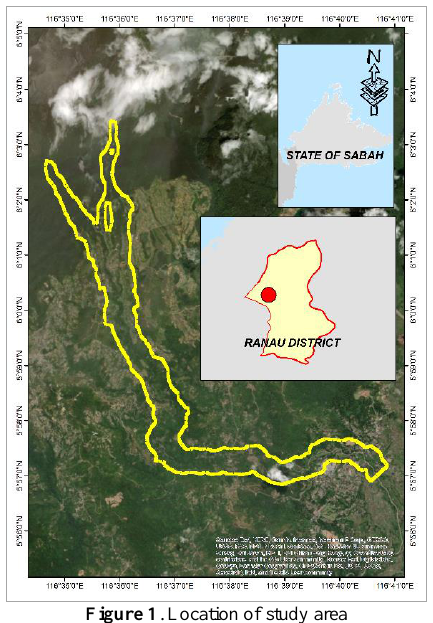
Figure 1 . Location of study